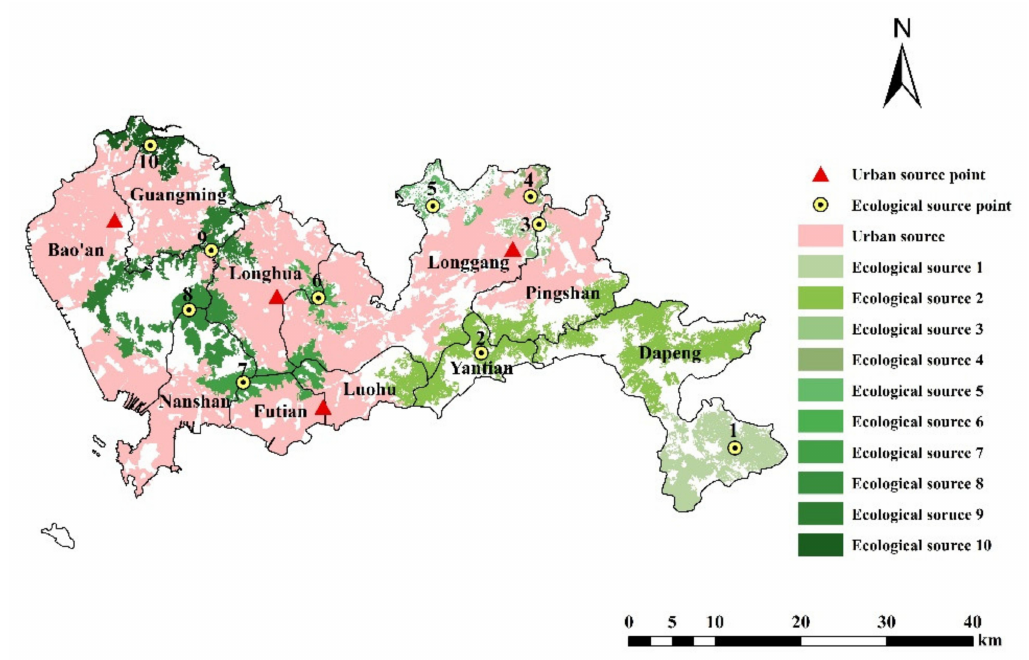
Figure 5. Distribution of ecological sources and urban